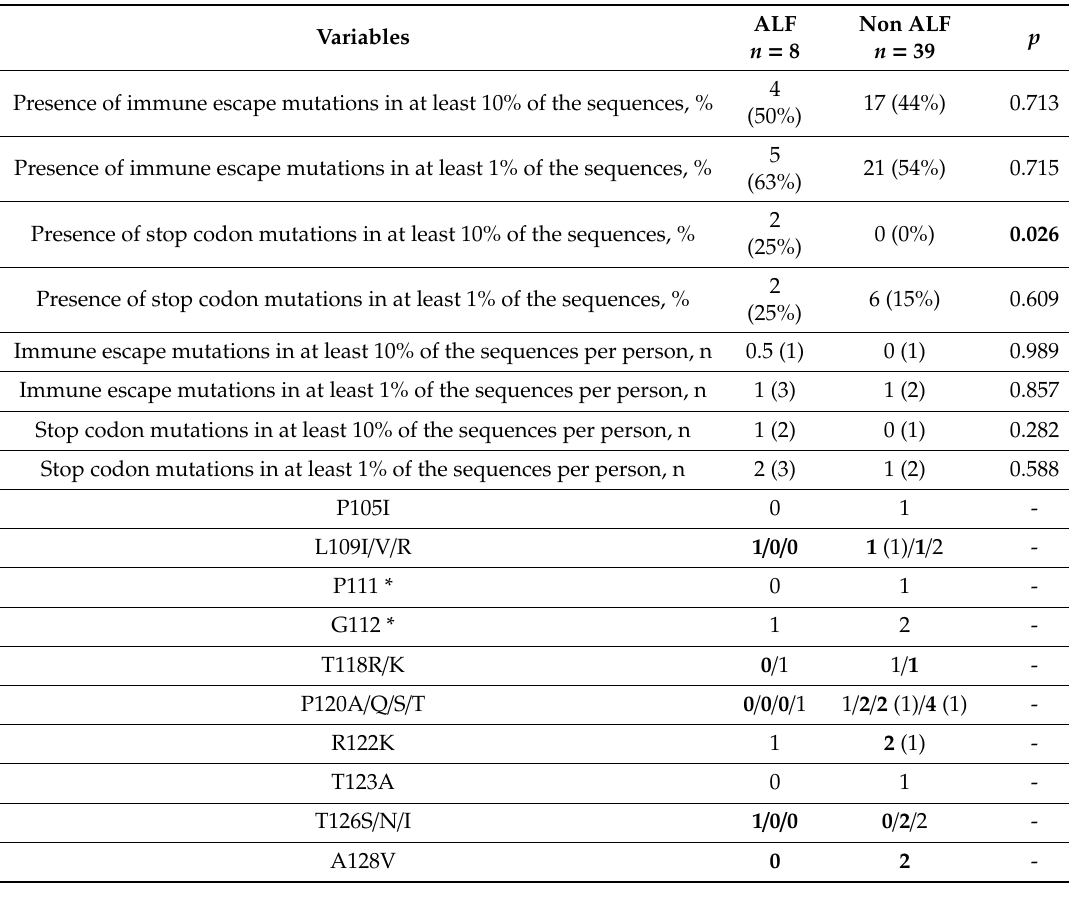
Table 3. Immune escape mutations and stop codons in SHB in patients with HBV reactivation stratified according to their liver function: ALF vs. non-ALF